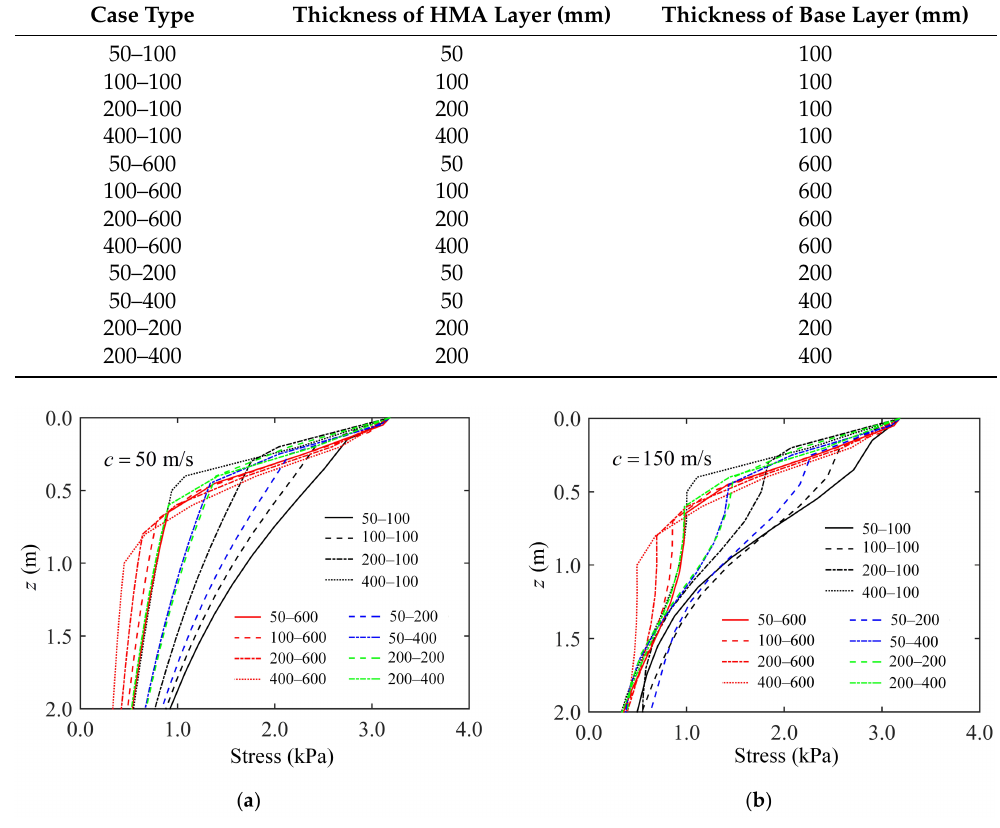
Figure 12. Effect of layer thickness on the vertical stress fluctuation amplitude along the z -axis, induced by a moving Gaussian load with speeds of ( a ) c = 50 m/s and ( b ) c = 150 m/s. The ground surface vibration velocity and the acceleration along the x -axis are pre- sented in Figures 13 and 14, respectively. This result shows that the changes are the same as they were for the stress under the ground. Note that a thicker overall layer can reduce the degree of tremor. Comprehensive analysis of the results indicates that the 200–400 mm case was the best at reducing dynamic vibration, regardless of the speed of the moving